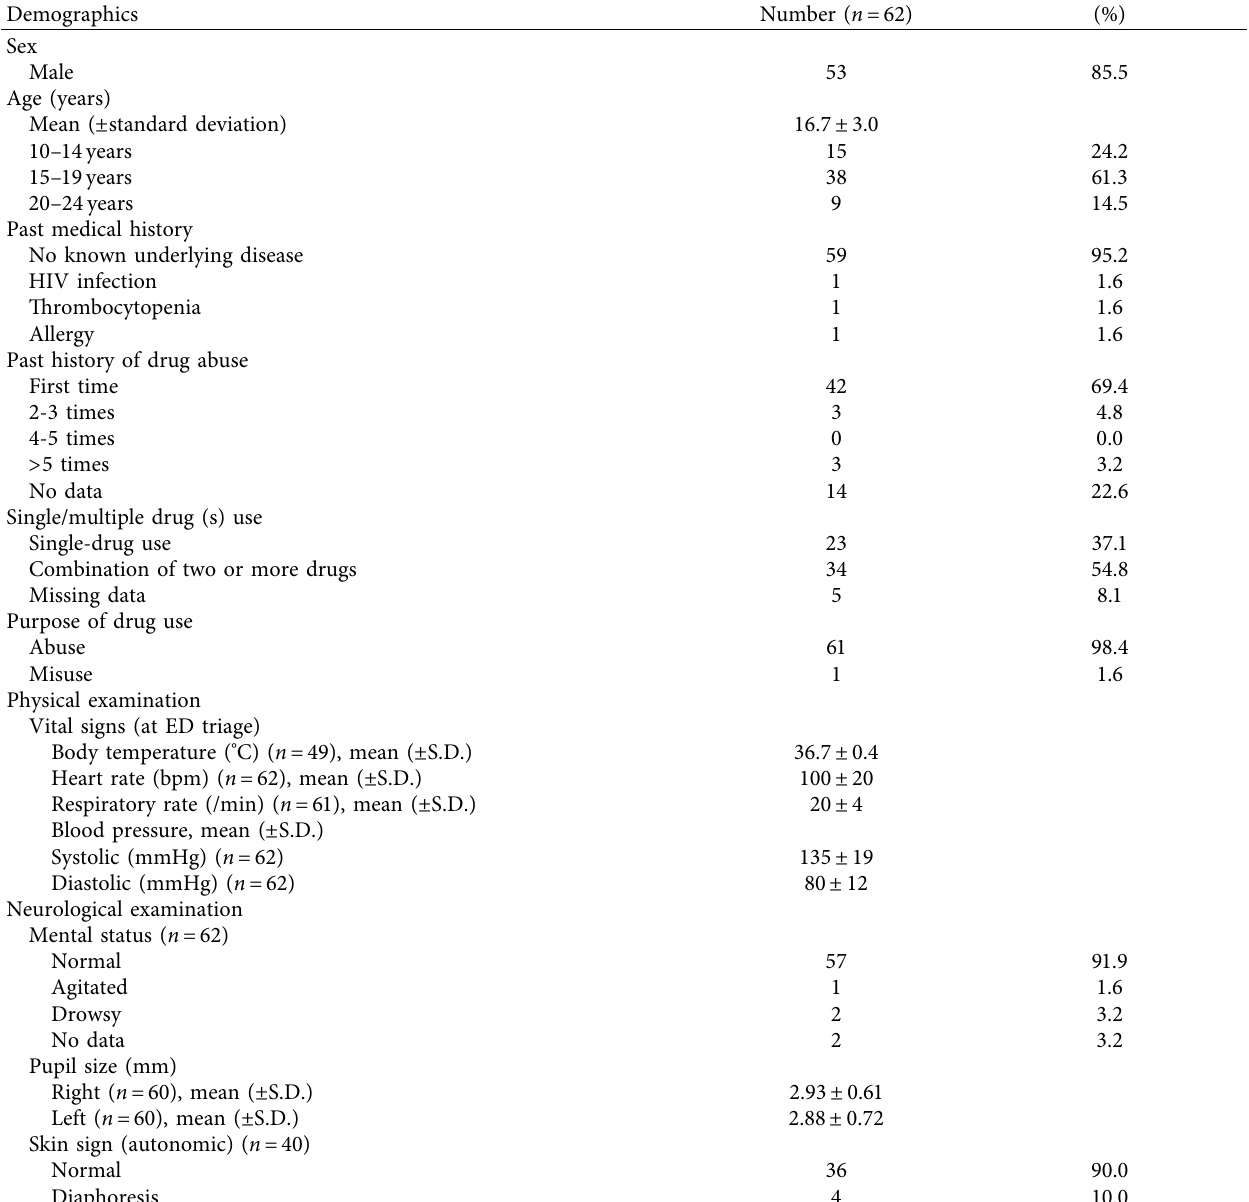
Table 2: Patient